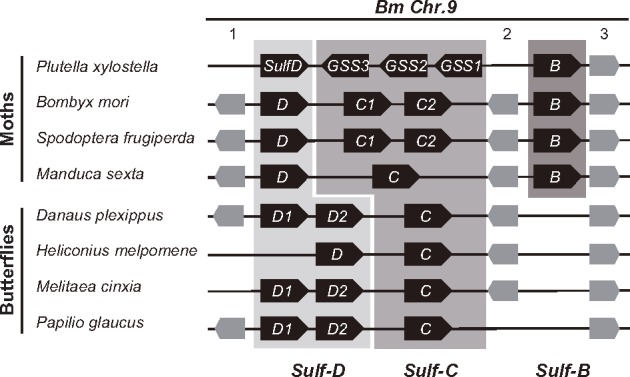

GSS genes are located in an ancient arylsulfatase gene cluster. This gene cluster consists principally of Sulf-D, -C, and -B genes, with lineage-specific duplications and deletions. In the Bombyx mori (Bm) genome, this cluster is located on Chromosome 9. Intervening genes code for inositol polyphosphate-1-phosphatase (1), an olfactory receptor (2), and fasciclin-1 (3). Note the inversion of GSS1–3 relative to flanking arylsulfatases.